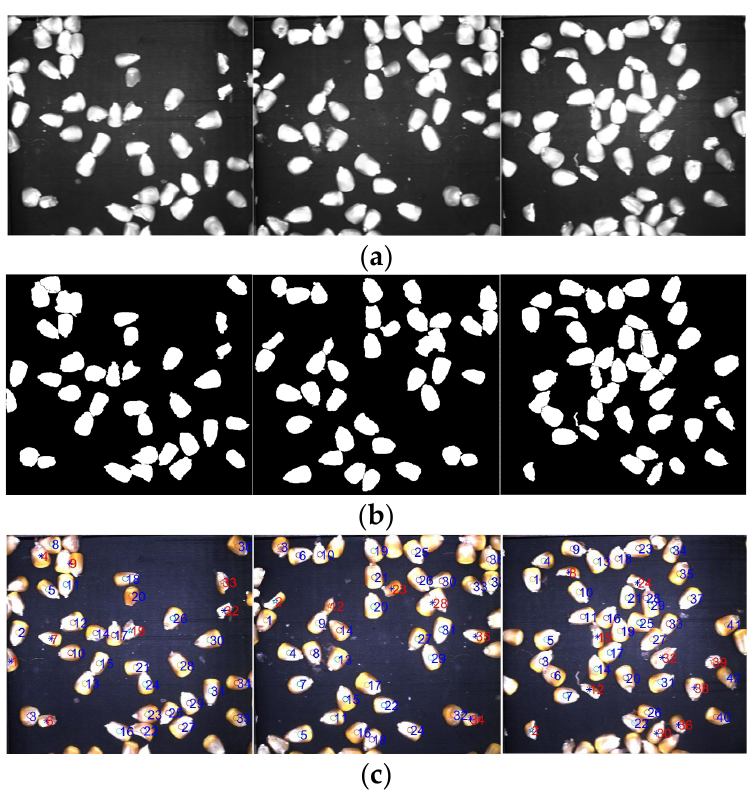
Figure 11. Image processing and labeling of harvested corn grains. ( a ) Grayscale image of harvested corn grains. ( b ) Boundary suppression binary map. ( c ) Corn grain harvest image marker.